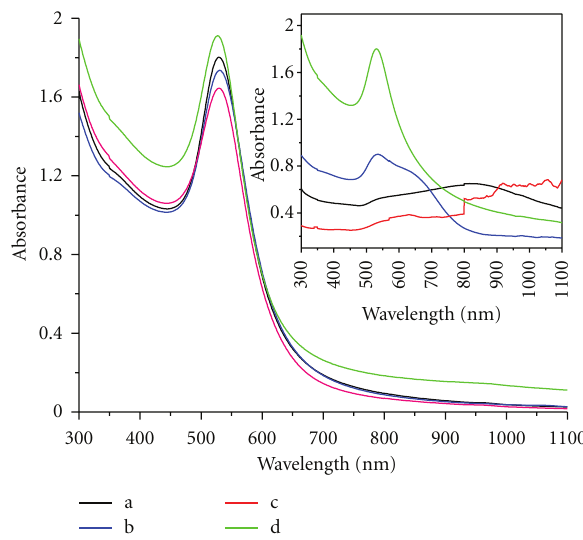
Figure 3: UV-vis spectra of AuNPs synthesized using various stabilizers: black line: PSS − , blue line: Nafion, red line: SDS − and light green line: PVP; Inset . UV-vis spectra of various stabilized AuNPs such as black line: PSS − , blue line: Nafion, red line: SDS − , and light green line: PVP by addition of 3M NaCl.